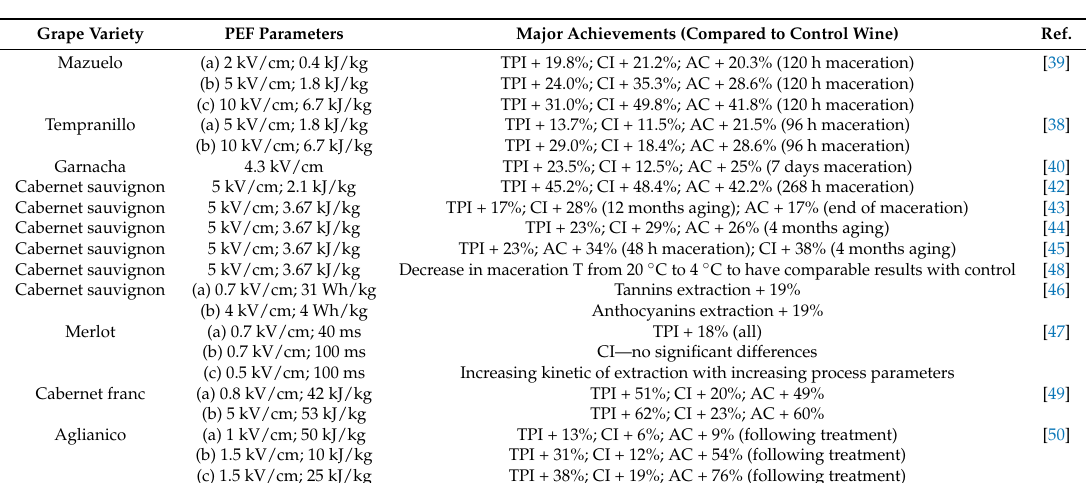
Table 1. Summary of the main findings in PEF experiments in relation to grape varieties and process parameters. Abbreviation: Total Polyphenols Index (TPI), Color Intensity (CI), Anthocyanins Content